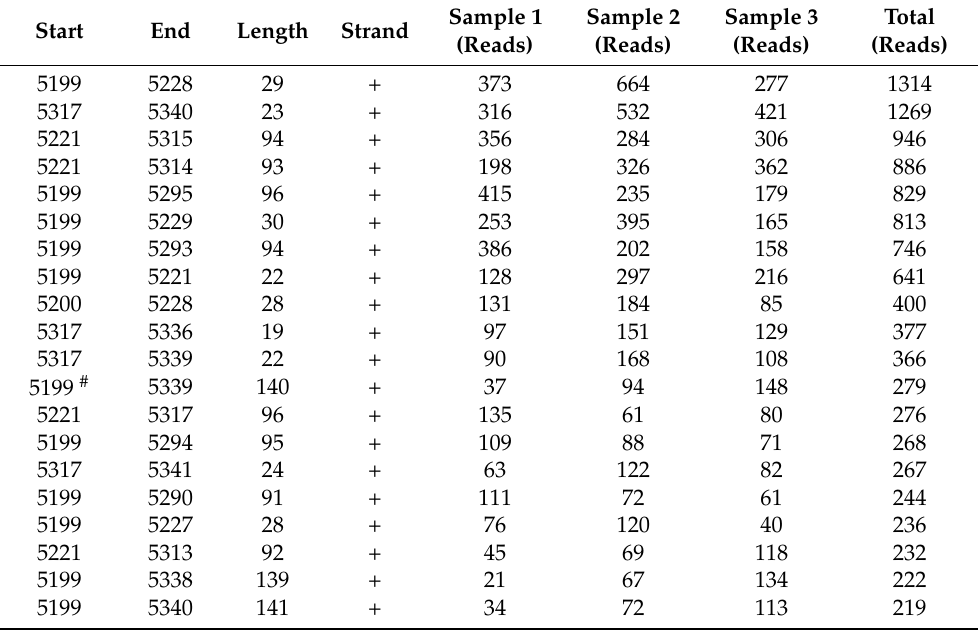
Table 4. Top 20 identified small RNAs by small